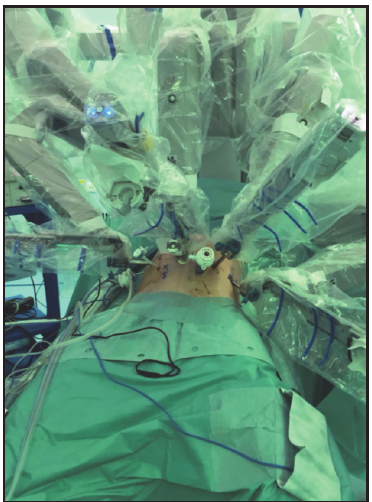
Figure 3: Port positioning for robot-assisted spleen preserving distal